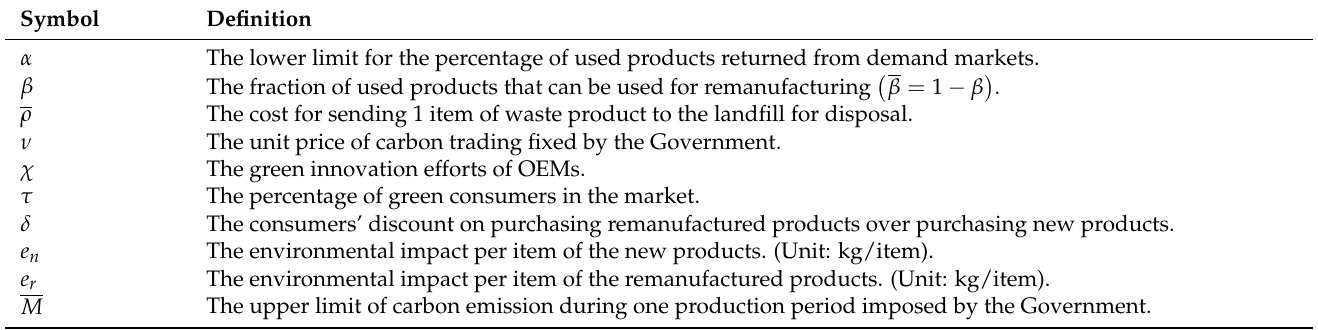
Table 3. The parameters in the IHRS